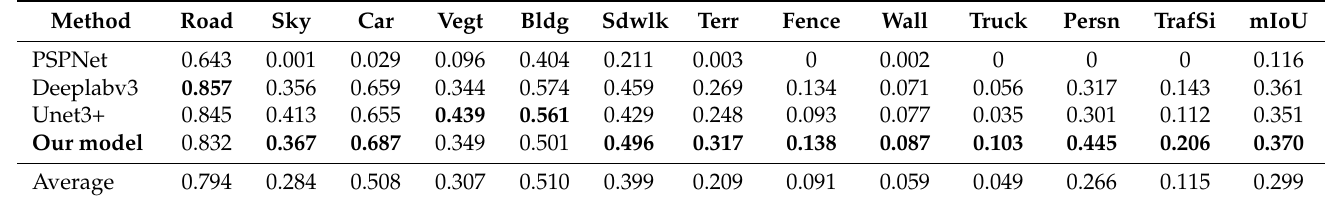
Table 9. Performance comparison of each model on the Rain Cityscape